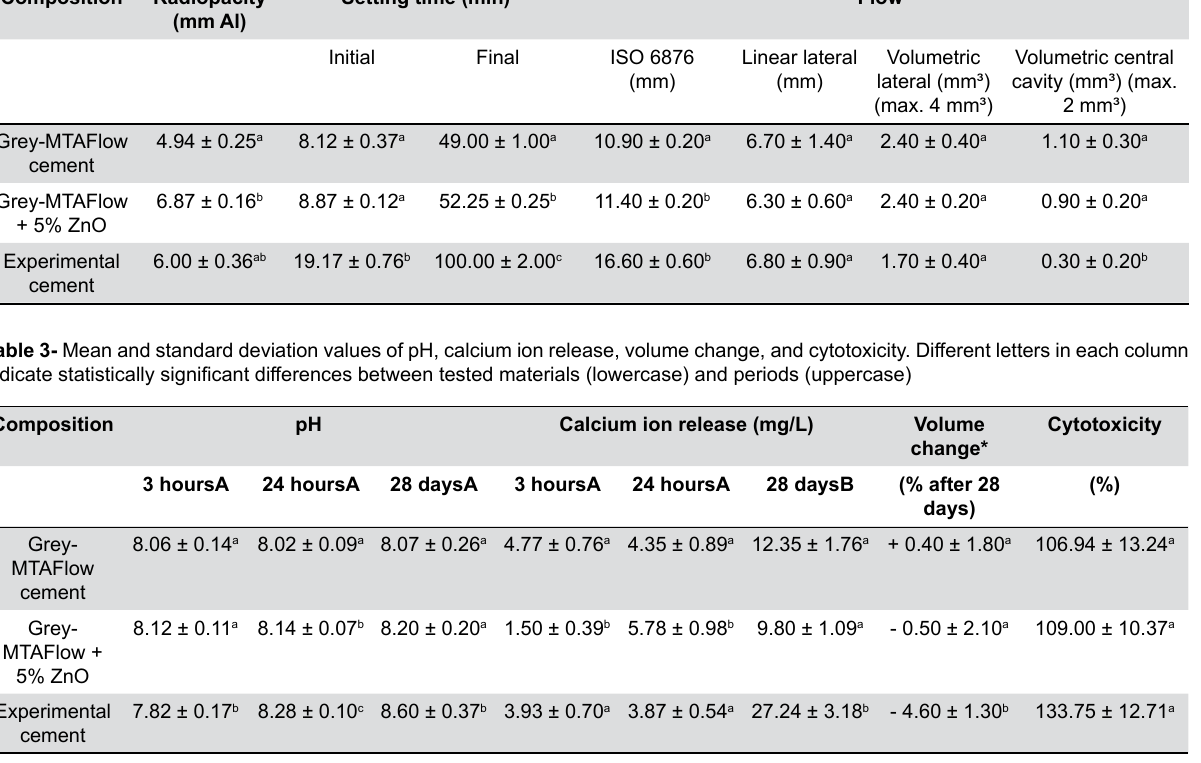
*Volume change negative values represent volume loss and positive values represents expansion.